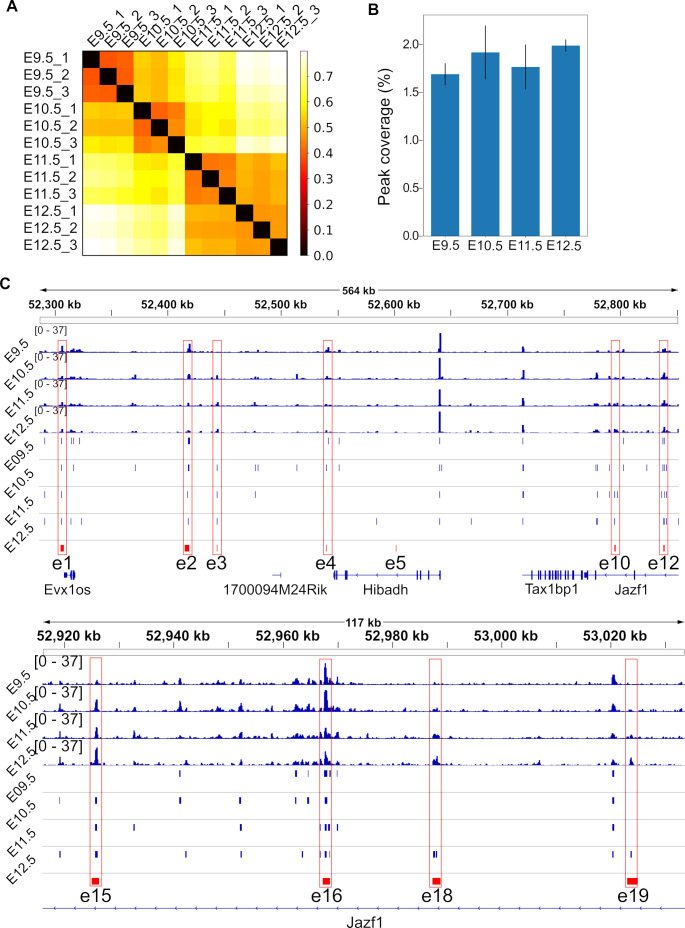
ATAC-seq quality control.(A) Correlation distance between samples. The numbers in the end of the sample names indicate the replicates of indicated stages. Darker color means more similar gene expressions. (B) Percentage of peak regions in the genome sequence. (C) ATAC-seq signals in BPM (blue signals), peak regions (blue rectangles) and the known limb enhancers of HoxA cluster (red rectangles, e1–e19). Note that only e5 is not covered by ATAC-seq data.